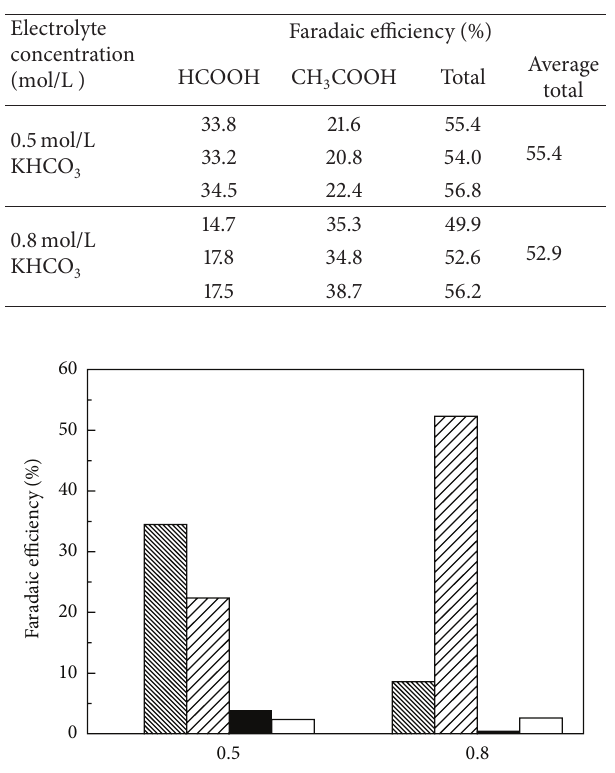
Table 1: Test of steady of Pd-MWNTs catalysts gas-diffusion electrode.